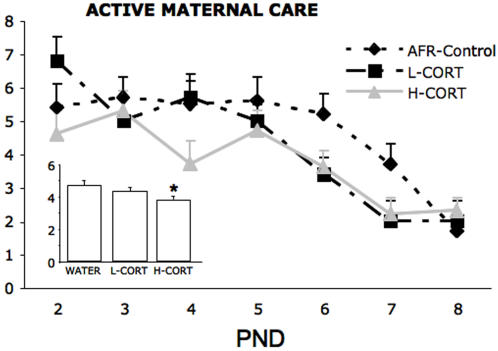
Effects of maternal CORT on maternal behavior.Daily frequency (mean/hour±SEM) of active maternal care shown by control, CORT-L and CORT-H dams (N = 8 dams per group); daily scores are based on 3 daily one-hour sampling sessions (10 observations/hour). Inset: total levels of active maternal care across days (mean frequency/hour±SEM). Scores from each of 3 daily one-hour sampling sessions were averaged across postnatal days 2 to 8.